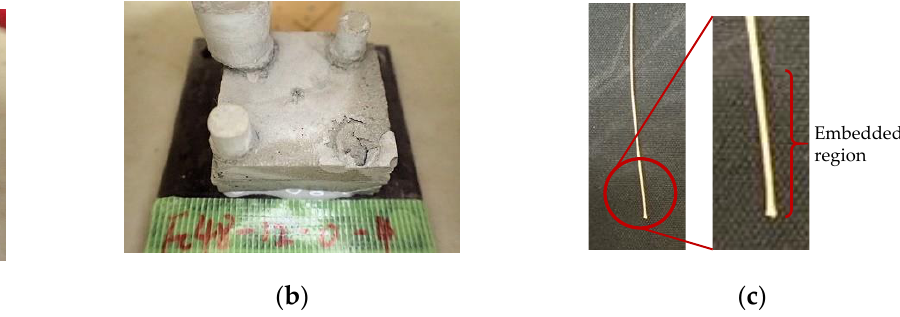
Figure 11. Example of pullout specimen: ( a ) before loading; ( b ) after loading; ( c ) pulled out fiber.